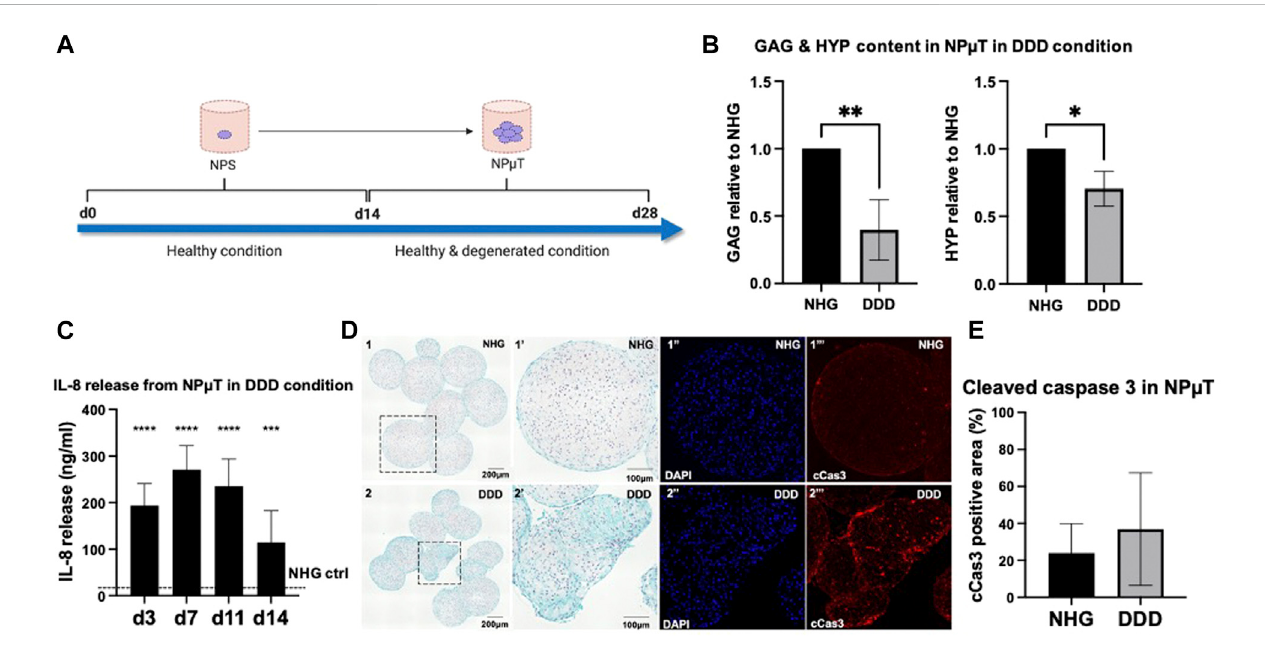
FIGURE 2 Development of 3D degenerative NP microtissue (µT) model. (A) NPµT was formed for 14d in NHG or DDD condition using NP spheroids (NPS) pre- cultured in healthy (NHG) condition for 14d. After 14d in NHG or DDD condition, NPµT was analyzed (B) biochemically by quantifying glycosaminoglycans (GAG) and collagens (HYP) ( n = 6, mean ± SD, *p < 0.05, ANOVA). (C) Catabolic shift in degenerative NPµT was assessed by measuring IL-8 release in culture medium onday3, 7,11and14.Dashed linerepresents IL-8 releaseinNHGcontrol(no IL-8detected)( n =5, mean±SD,*p < 0.05 vs.NHGctrl., ANOVA). ( D ) NPµT formed in ( D1 ) NHG or ( D2 ) DDD condition was stained with SafO/FG ( (D1 ’’ ) zoomed D1 showing healthy cells producing proteoglycans, (D2 ’’ ) zoomed D2 showing cells with moderate proteoglycan production) and immuno fl uorescence ( (D1 ’’ - 2 ’’ ) DAPI and (D1 ’’’ -D2 ’’’ ) cleaved caspase 3 (cCas3) visualising nuclei (in blue) and apoptotic cells (in red), respectively) ( n =6). (E) Quanti fi cation of cCas3 staining in NPµT ( n = 6, mean ± SD, *p < 0.05,